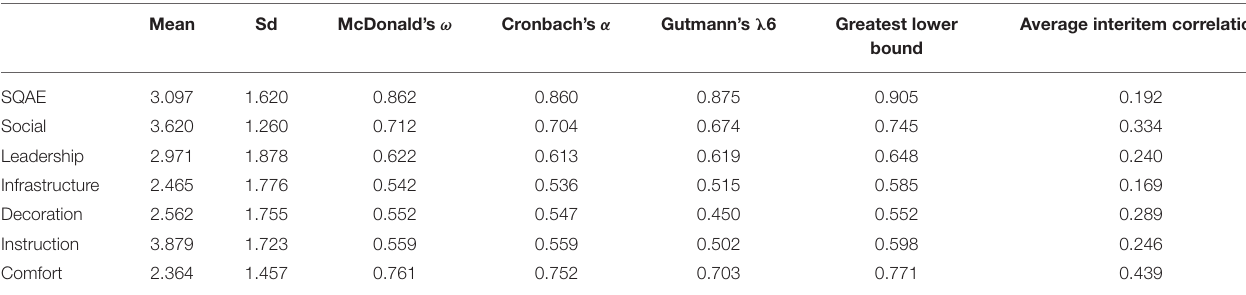
TABLE 4 | Scale reliability